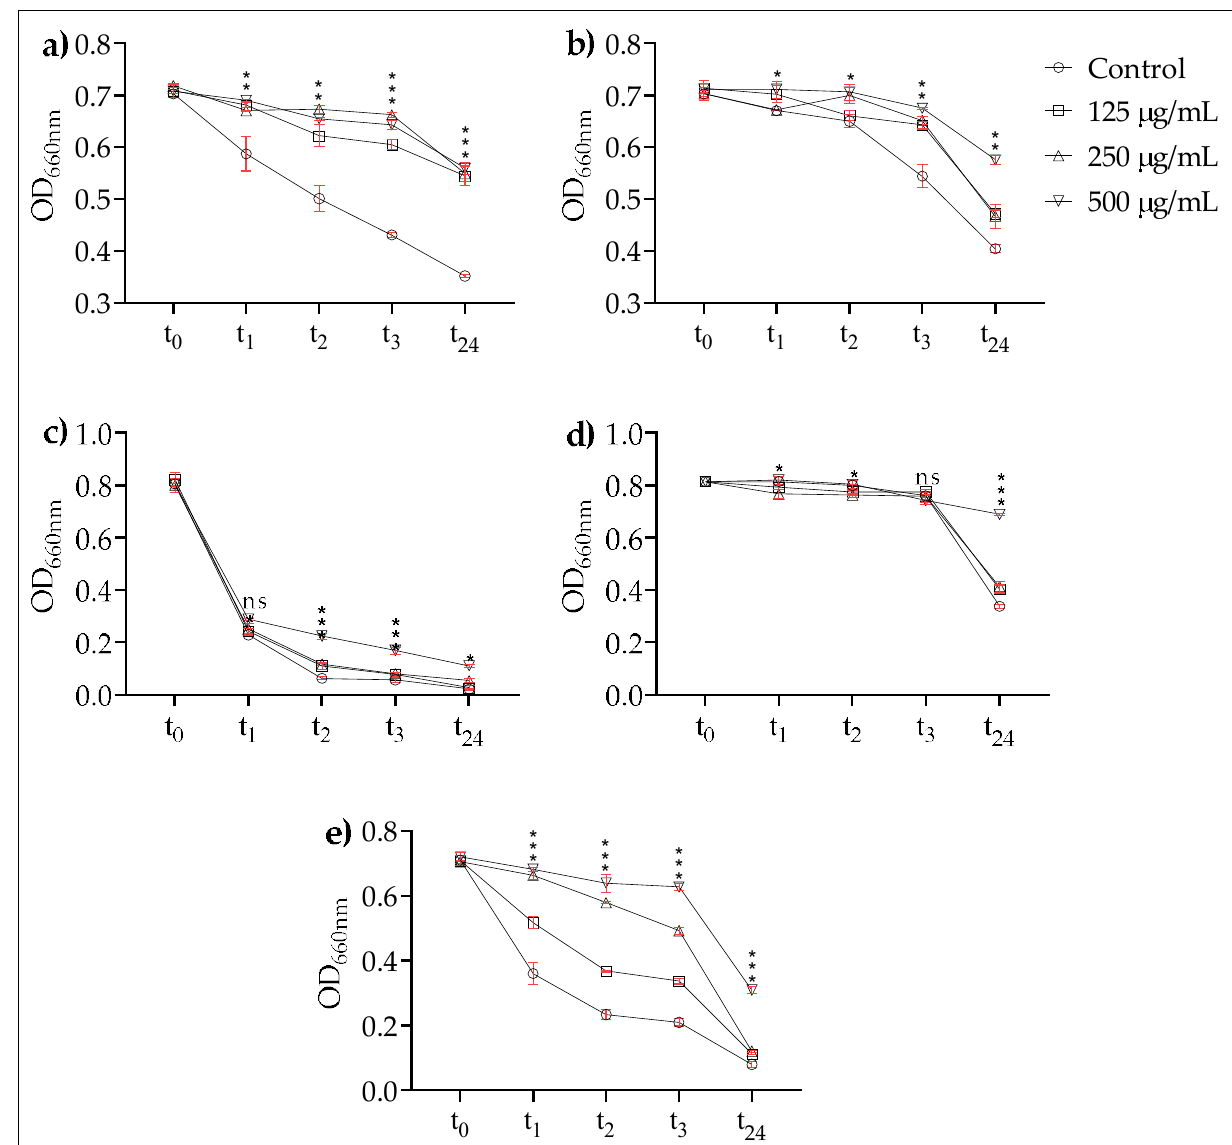
Figure 4. Effects of EPS on co-aggregation. ( a ) P. denticola ATCC. ( b ) P. denticola AHN 33266. ( c ) P. gingivalis ATCC 33277. ( d ) P. gingivalis AHN 24155. ( e ) Fil. alocis ATCC 35896. ns: not significant, ***: p < 0.001; **: p < 0.01; *: p < 0.05. Dots include standard deviation.